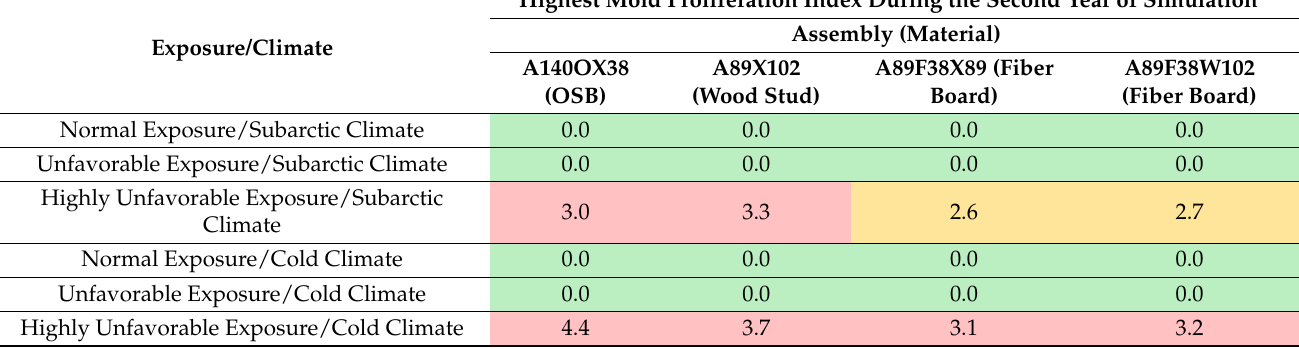
Table 7. The highest mold proliferation index during the second year of simulation as a function of the conditions and climate of the wall